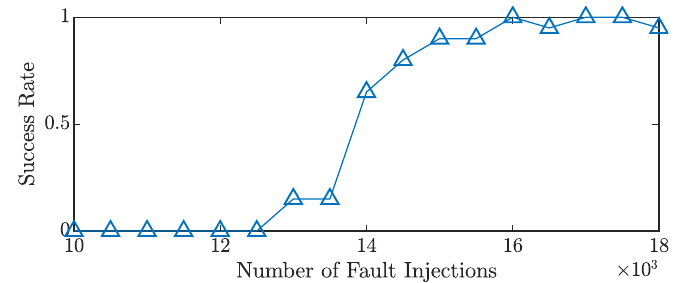
Figure 11: Attack success rate for NewHope512 as function of faulted